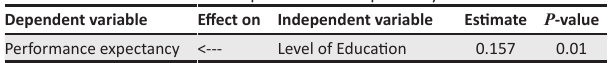
TABLE 1: Level of education and performance